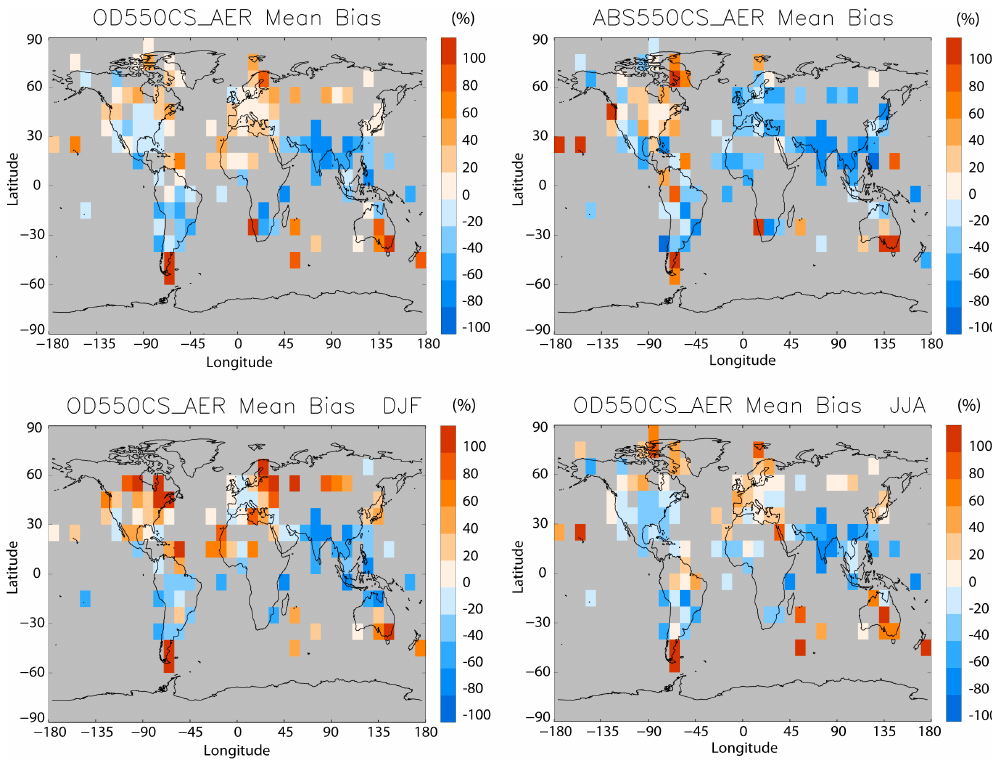
Fig. 8. Biases compared to AERONET (in %) in estimated clear-sky aerosol optical depth (AOD at 550nm, upper left and lower panels) and aerosol absorption optical depth (ABS at 550nm, upper right panel) with CAM4-Oslo. AOD and ABS biases in the upper row are yearly averaged, and AOD biases in the lower row are for NH winter (DJF) and summer (JJA). The AERONET retrievals are from the period 2000–2009, and are made available through the AeroCom